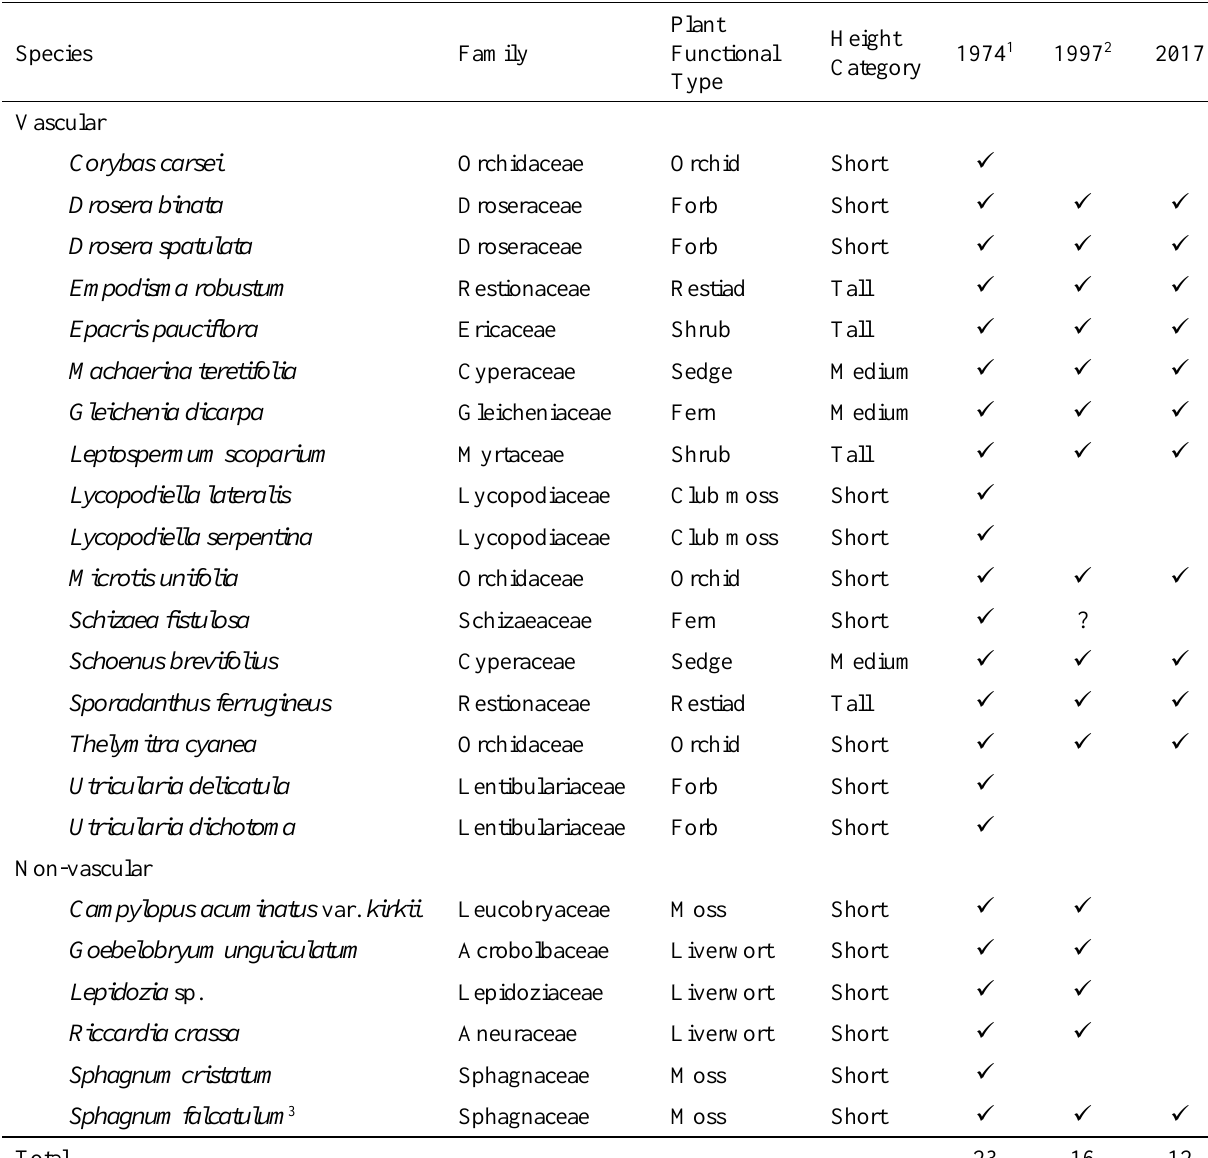
Table 2. List of restiad species and plant functional types recorded in Moanatuatua Bog in 1974, 1997 and 2017. Height categories: Short < 0.3 m, Medium 0.3–1.0 m, Tall > 1.0